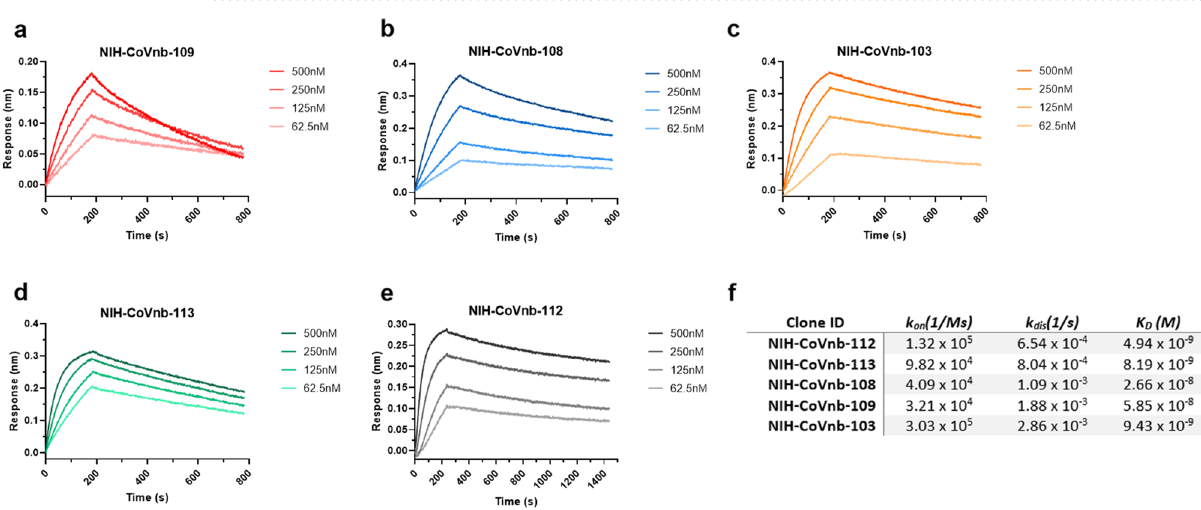
Figure 3. Affinity binding curves of isolated anti-SARS-CoV-2 RBD nanobodies. Using Biolayer Interferometry on a BioForte Octet Red96 system, association and dissociation rates were determined by immobilizing biotinylated-RBD onto streptavidin coated optical sensors ( a – e ). The RBD-bound sensors were incubated with specific concentrations of purified candidate nanobodies for a set time interval to allow association. The sensors were then moved to nanobody-free solution and allowed to dissociate over a time interval. Curve fitting using a 1:1 interaction model allows for the affinity constant (K D ) to be measured for each nanobody as detailed in ( f